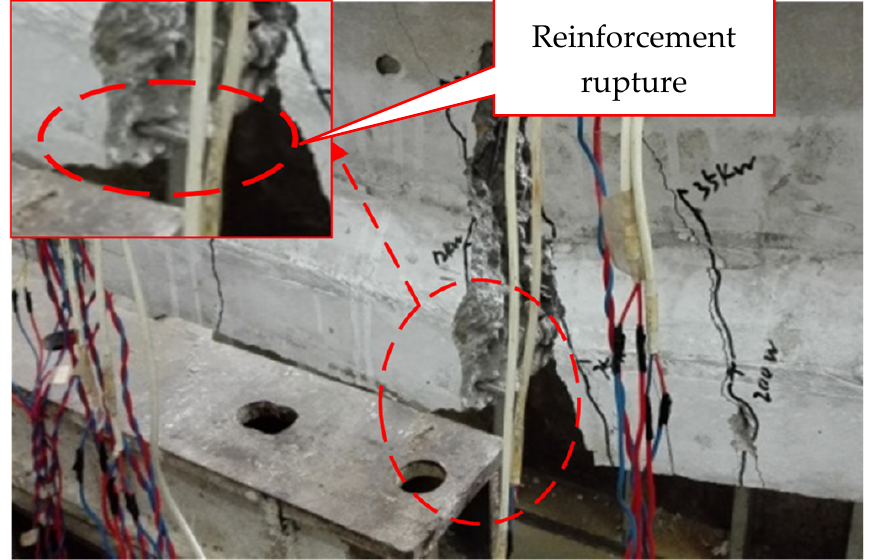
Figure 7. The fatigue failure mode of the test beam.